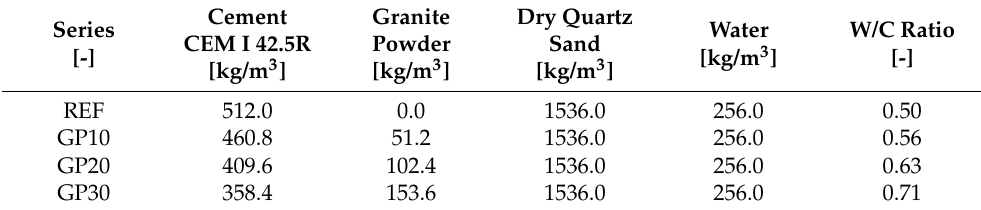
Table 1. Compositions of individual floor mortar